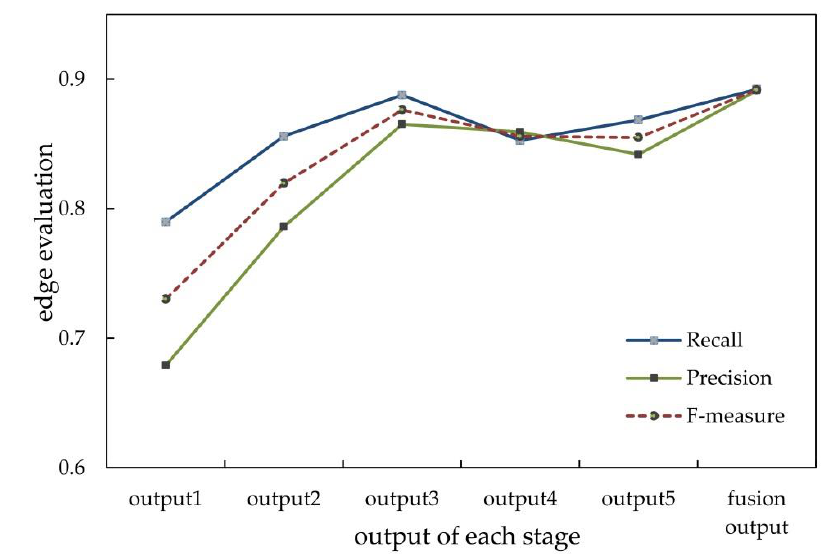
Figure 11. Comparison of precision, recall and F-measure of the output maps at different stages.